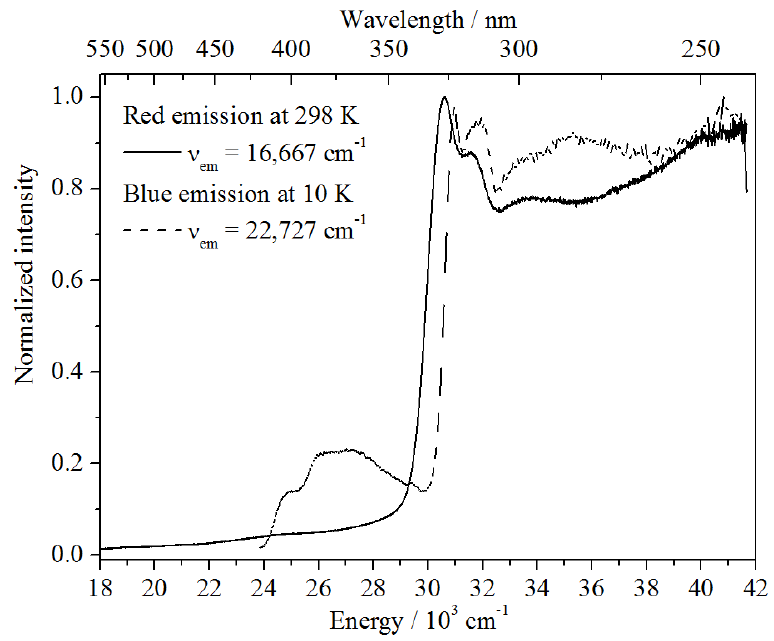
Figure 11. Excitation spectra of the red emission band at 10 K (bold curve) and of the blue emission band at 298 K (dashed